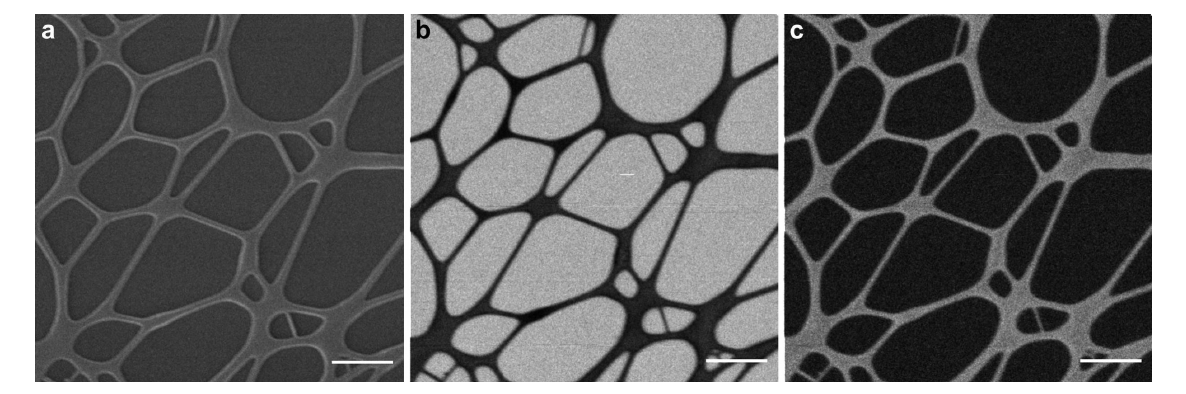
Figure 2: Micrographs of lacey carbon on carbon film. (a) Secondary electron imaging mode, (b) bright-field STIM image, with collection angle from 0 to 3°, and (c) annular dark-field STIM image, with collection angle from 8 to 13.9°. The scale bars are 1 μ m.